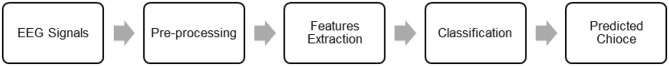
EEG-based BCI for preference recognition.